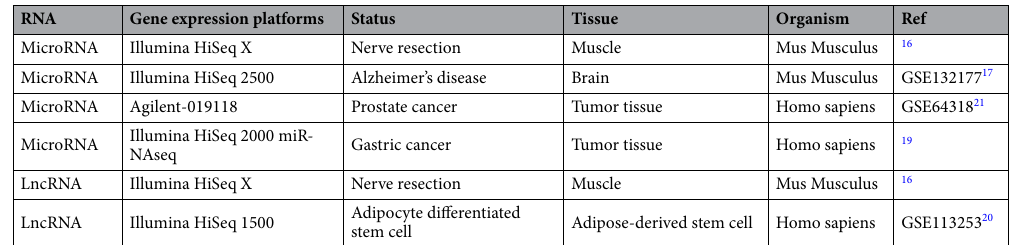
Table 1. Description of publicly available data sets used in the meta-analysis. Ref: